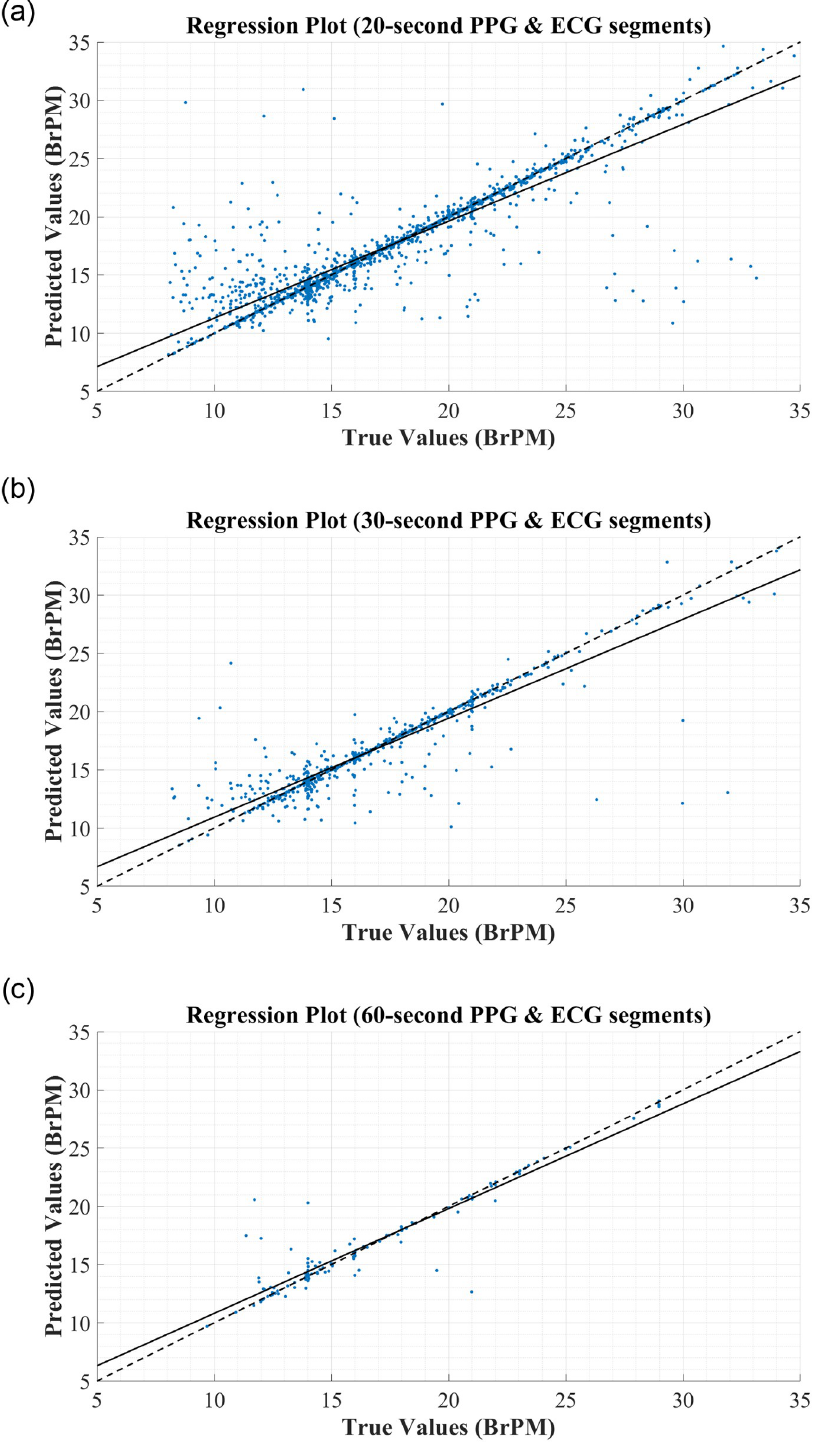
Fig 5. Regression Plots for RR Estimation using RR & RQI features derived from: (A) 20-second PPG & ECG segments. (B) 30-second PPG & ECG segments. (C) 60-second PPG & ECG segments.